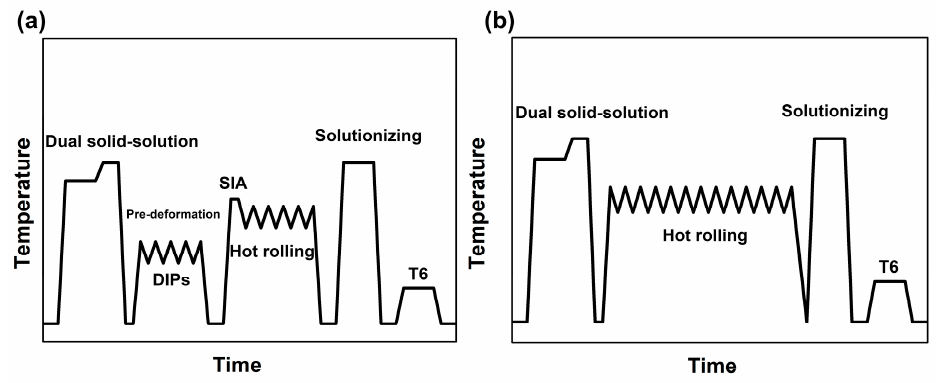
Figure 1. Schematic presentation of thermomechanical processings (TMPs): ( a ) MSR; ( b ) CHR.